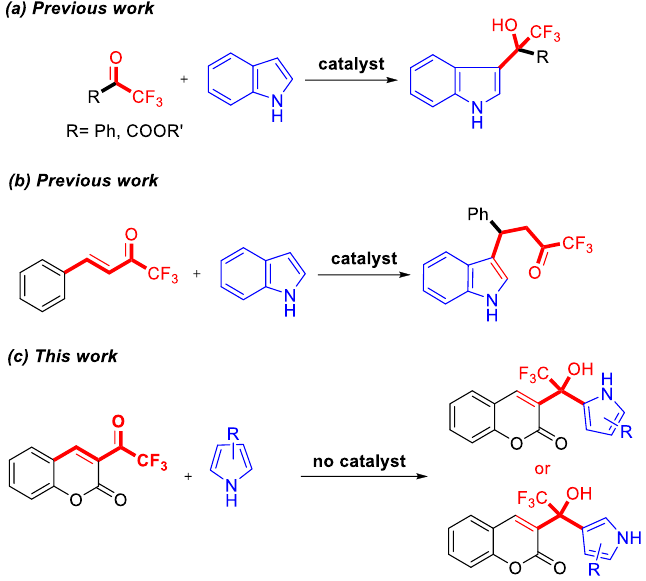
Figure 2. Friedel –Crafts alkylation of indole or pyrrole and trifluoromethylketone or α,β -unsatu- Figure 2. Friedel–Crafts alkylation of indole or pyrrole and trifluoromethylketone or α , β -unsaturated rated trifluoromethyl ketone. trifluoromethyl